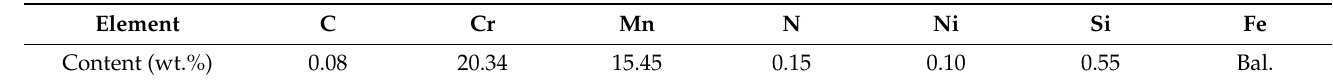
Figure 1. SEM morphology of the as-received stainless steel powders. Table 1. Chemical composition of as-received stainless steel powders. Element